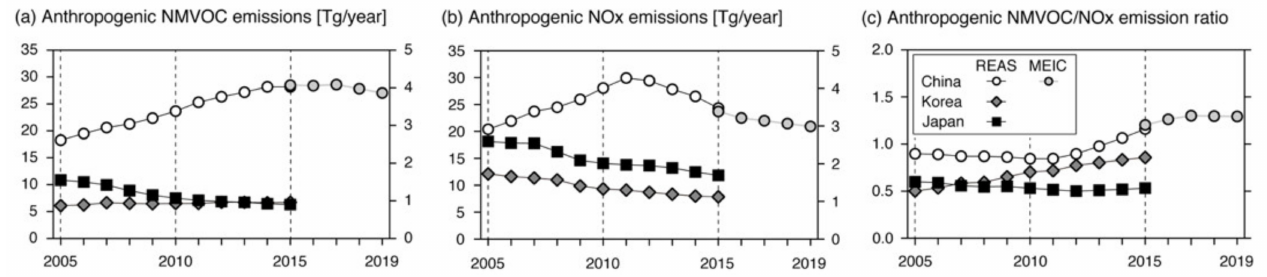
Figure 6. Annual amounts of anthropogenic emissions of ( a ) NMVOC and ( b ) NO x , and ( c ) the NMVOC/NO x ratio over China (white circles, left axis), the Republic of Korea (gray diamonds, right axis), and Japan (black squares, right axis) during 2005–2015 calculated from REAS. The values over China during 2015–2019 calculated from MEIC are also shown (light-gray circles, left